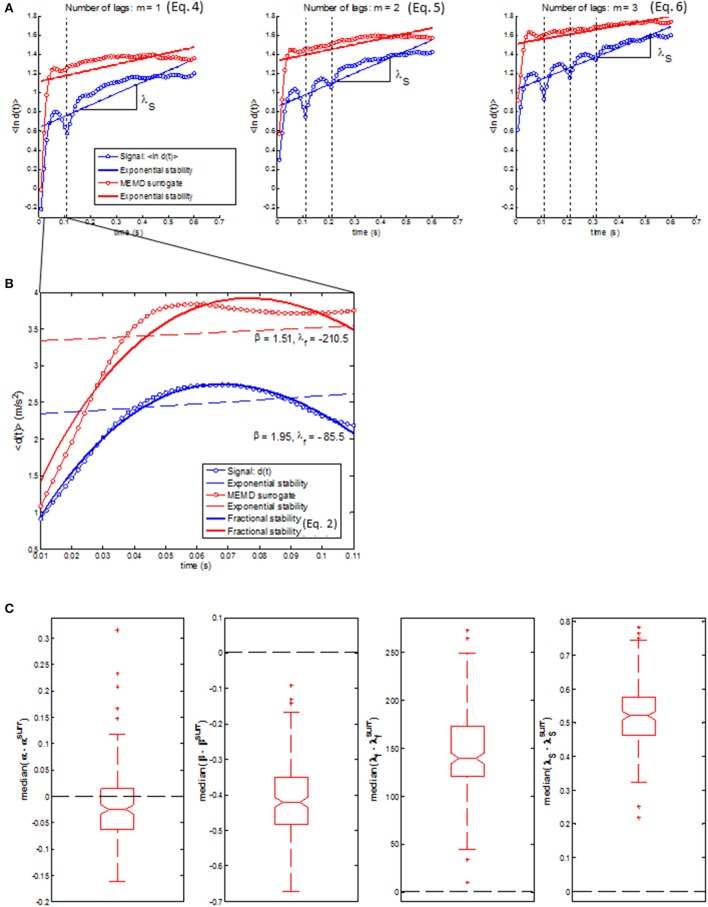
(A) A representative example of the difference between d(t) of the original trunk acceleration (blue trace) and d(t) of the MEMD surrogates (red trace) where the regression line used to calculate λS is a bold blue and red line, respectively. (B) The up-sampled d(t) from initial perturbation d(0) to the first singularity of the original trunk acceleration (blue trace) and d(t) of the MEMD surrogates (red trace) where the nonlinear least square fit of Equation (2) is shown as a bold blue and red curve, respectively. (C) Boxplots of the median difference between fractional stability of the original trunk acceleration and the MEMD surrogates; median (α−αsurr) (left), median (β−βsurr) (middle left), median (λf-λfsurr) (middle right), and median difference between exponential stability of the original trunk acceleration and the MEMD surrogates; median (λS-λSsurr). Note that the center of the box represents the median and the upper and lower borders of the box represent the 75th and 25th percentile, respectively. The whiskers represent the most deviating values within 1.5 times the interquartile range from the median value whereas values outside this range are represented as outliers.